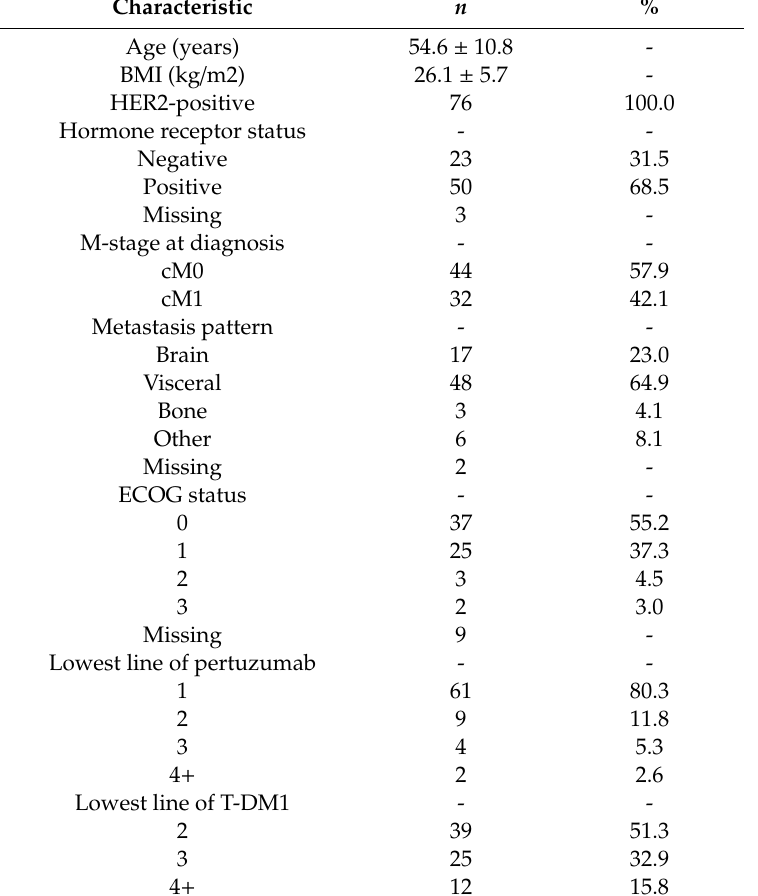
Table 1. Patient